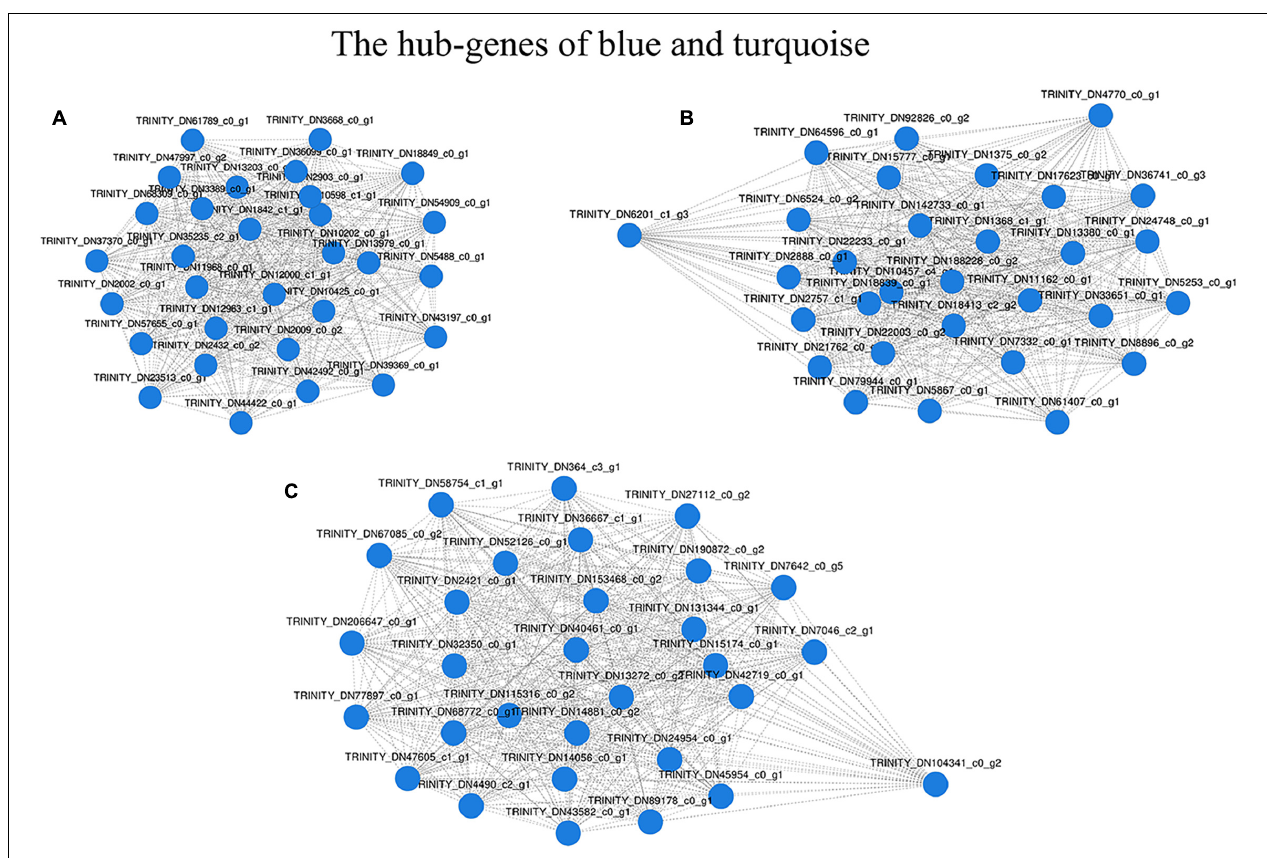
FIGURE 8 | Network of the most connected hub-genes. (A) Gene co-expression network in the “blue” module. (B) Gene co-expression network1 in the “turquoise” module. (C) Gene co-expression network2 in the “turquoise”